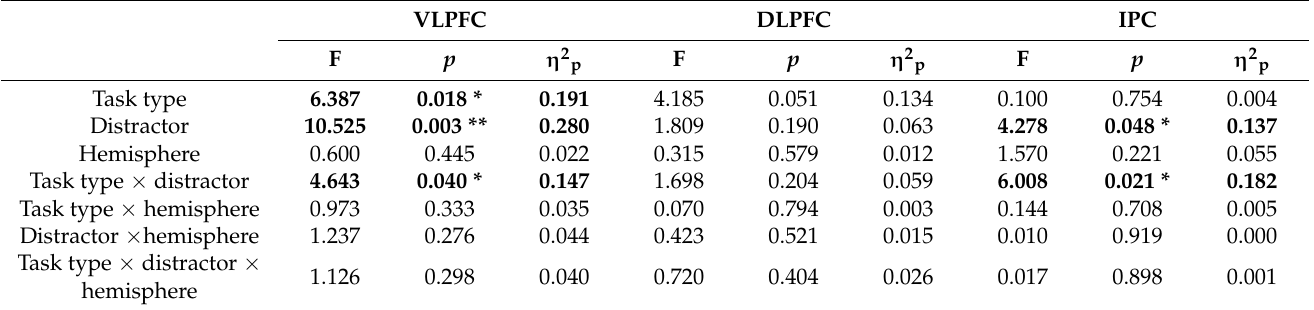
Table 2. Summary of 2 × 2 × 2 repeated-measurement ANOVAs in each brain